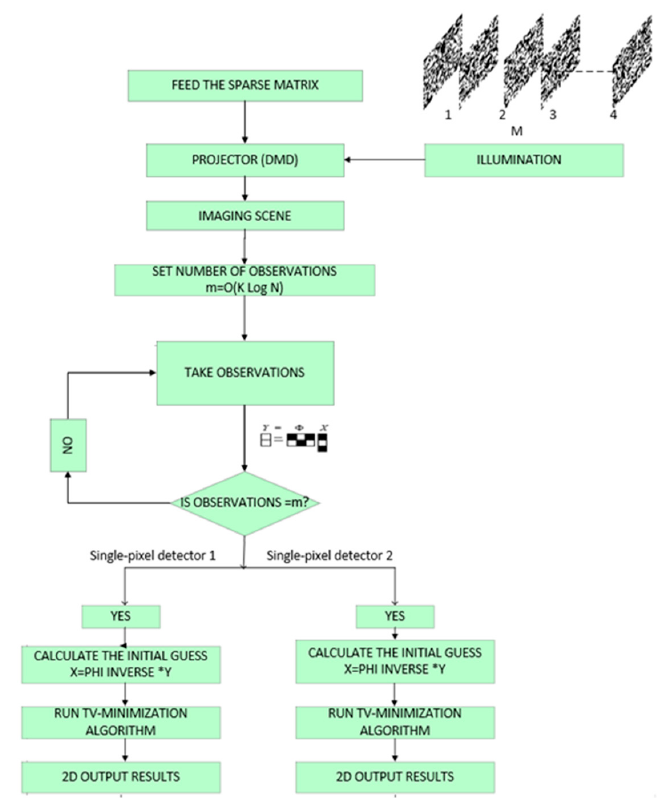
Figure 3. Flowchart of transparent object detection process.